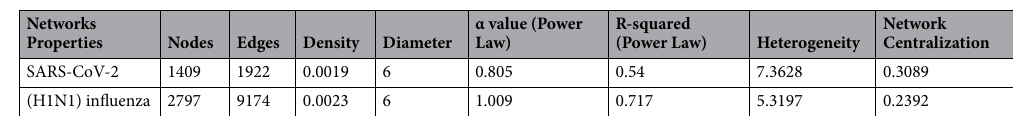
Table 4. Network global properties of SARS-CoV-2 and (H1N1) influenza PPINs.